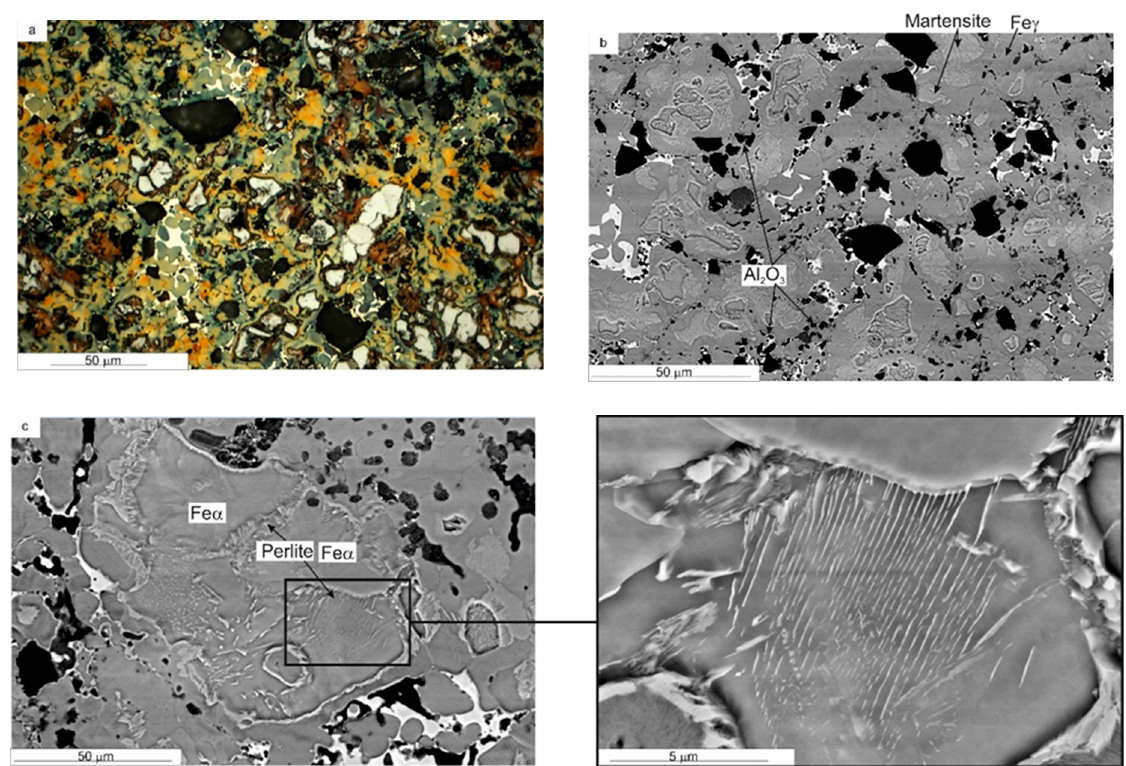
Figure 6. Microstructures of iron-based metal-matrix composites with the addition of 10 wt.% Al 2 O 3 sintered by SPS at 900 °C: ( a ) LM; ( b,c ) SEM.